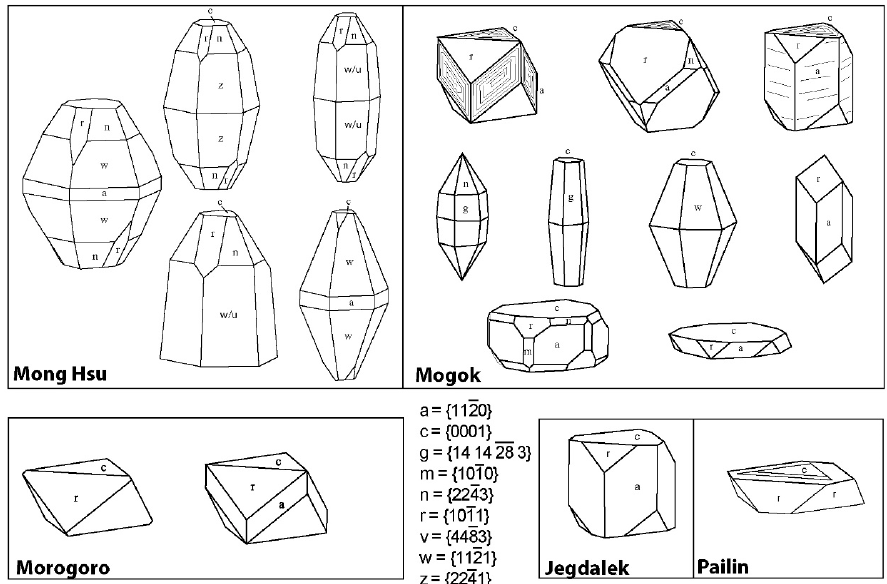
Figure 9. Main habits of ruby from different marble-hosted deposits: Mong Hsu and Mogok in Myanmar, Morogoro in Tanzania, and Jegdalek in Afghanistan. The rubies from the Pailin deposit (Cambodia) are from alkali-basalt placer deposits. From [5,30,45,48].